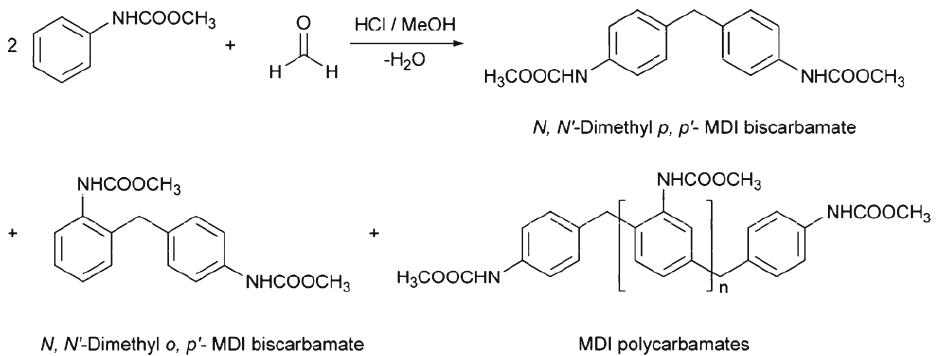
Figure 33. Condensation of N-methyl phenylcarbamate with formaldehyde (synthesis of 4,4 ′ -DN-MDC). From reference [17].